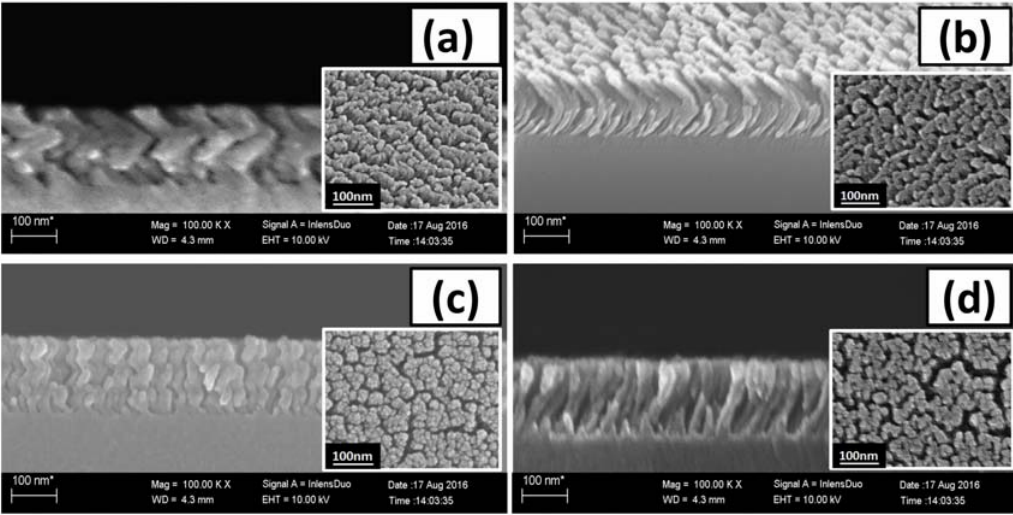
Figure 1. Cross ‐ sectional images of SiO 2 nanostructures: ( a ) nanozigzag; ( b ) C ‐ Shape; ( c ) nanohelix; Figure 1. Cross-sectional images of SiO 2 nanostructures: ( a ) nanozigzag, ( b ) C-Shape, ( c ) and ( d ) slanting nanorods. The inset in each figure represents the top view morphology of thin films.